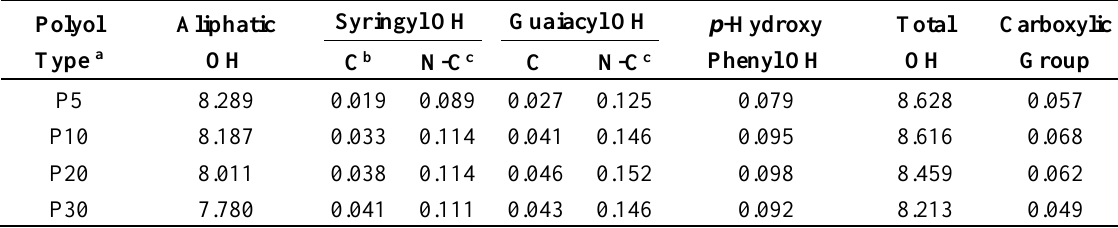
Table 3. Quantification of the lignin-derived polyols by the quantitative 31 P-NMR method.